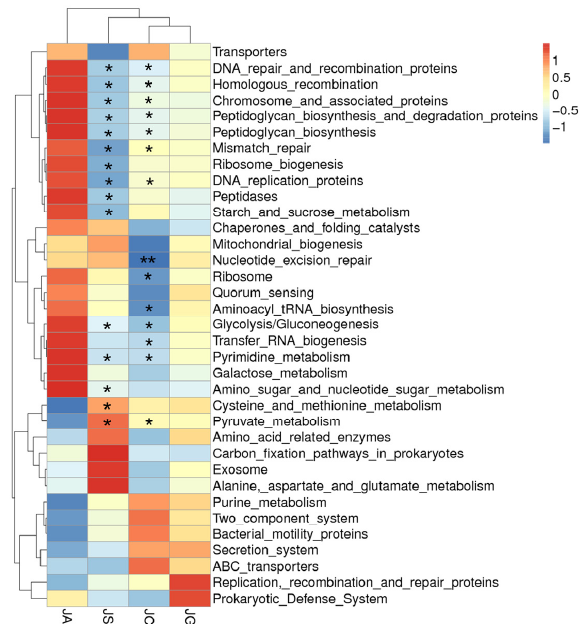
Figure 10. Cluster heatmap of the function prediction of strains with varying abundances. Black * marked in the graph represents the p -value of LP-cs vs. ALI and control vs. ALI. n = 3 per group. JC, control; JA, ALI; JS, LP-cs; JG, LP-cs-Gel. * p < 0.05, and ** p < 0.01.